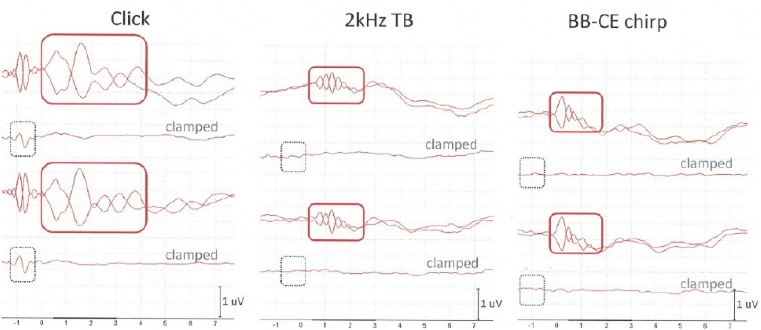
Figure 3. Example of a single subject showing from top to bottom: CMs (both polarities superimposed, 3.3 Hz HPF), the clamped tube condition (no CM), CMs (both polarities superimposed, 300 Hz HPF), clamped tube condition (no CM) evoked by a click, typical for all subjects (left graph), by a tone burst (atypical response: middle graph) and by a BB-CE chirp stimulus (atypical response: right graph). Note: in contrast to conventional lower stimulation rates used for SP/AP recordings, a higher stimulation rate was used to obtain CMs (87.1 Hz). Black rectangles: residual electrical stimulus artifact; red rectangle: CM response.